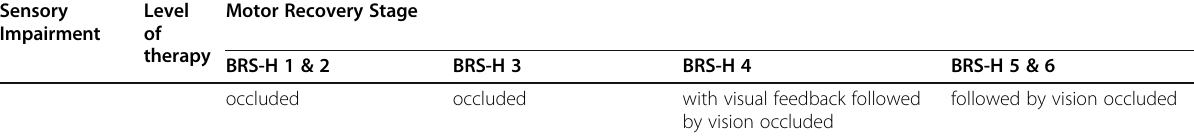
Table 1 Experimental intervention as per the type of sensory impairment and motor recovery stage of the hand (Continued) Sensory